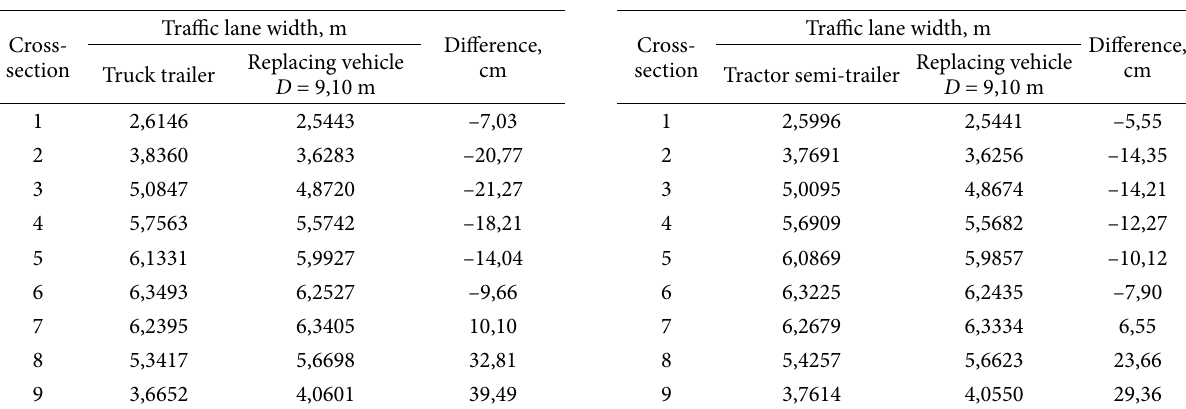
fig. 7. Setting a complex vehicle movement trajectory (truck semitrailer) by the method of reduced wheel base Table 3. Difference in traffic lane width for truck trailer and their replacing vehicle (Fig. 7)